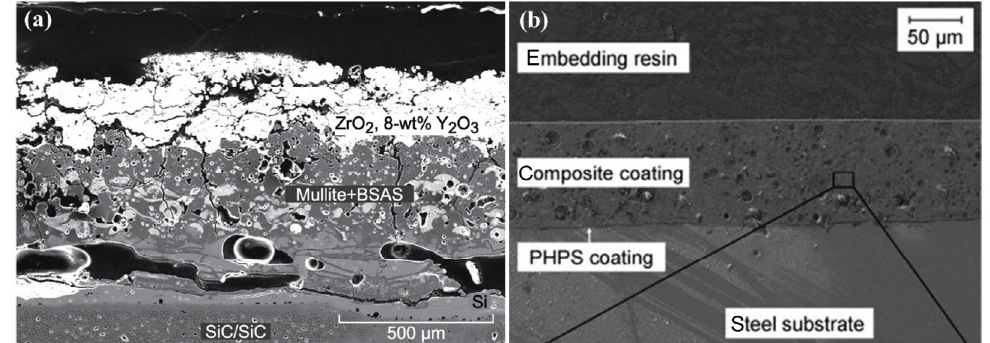
Fig. 11 (a) Typical T/EBC systems for CMCs used in gas turbine engines. Reproduced with permission from Ref. [292], © American Society of Civil Engineers 2013. (b) A polymer-derived EBC system consisting of a SiNO bond coat and a ZrO 2 -filled SiCN glass/ceramic composite coat. Reproduced with permission from Ref. [9], © Elsevier Ltd.